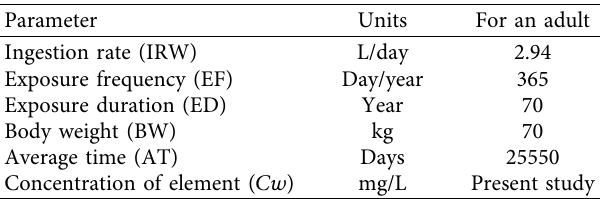
Table 3: The key parameters for computing the CDI of nephrotoxic elements through drinking water.